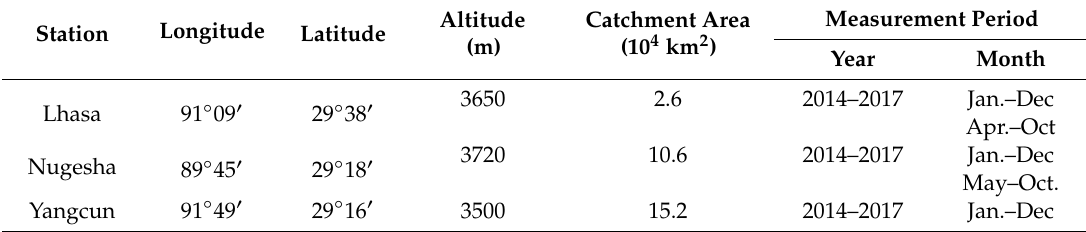
Table 1. Basic information of the hydrological gauging stations.